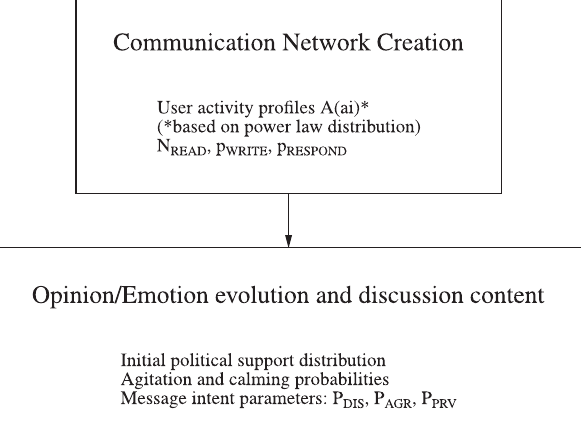
Figure 1. Block diagram of the two simulation subprograms. The first subprogram creates the communication network, using the listed parameters, the second provides the individual evolution of emotions and opinions as well as the intent of the messages exchanged in the discussions. For each set of parameters the network is generated between 10 and 25 times; then for each network instance the process of modelling the opinion ane emotion evolution is repeated 200 times.